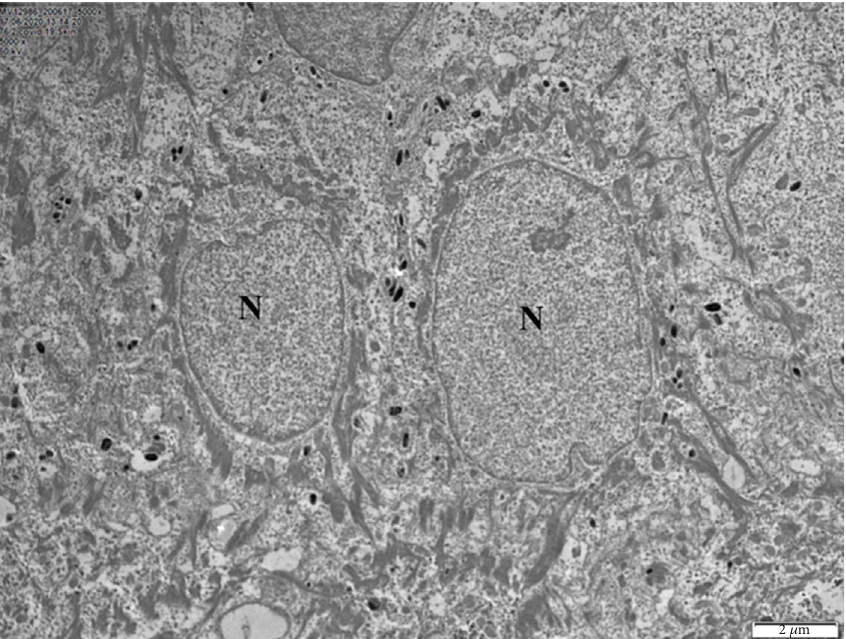
Figure 3: Representative transmission electron micrographs from skin biopsy illustrating the ultrastructure of typical keratinocytes in the stratum spinosum. Ν represent nucleus. No structures consistent with viral inclusions were